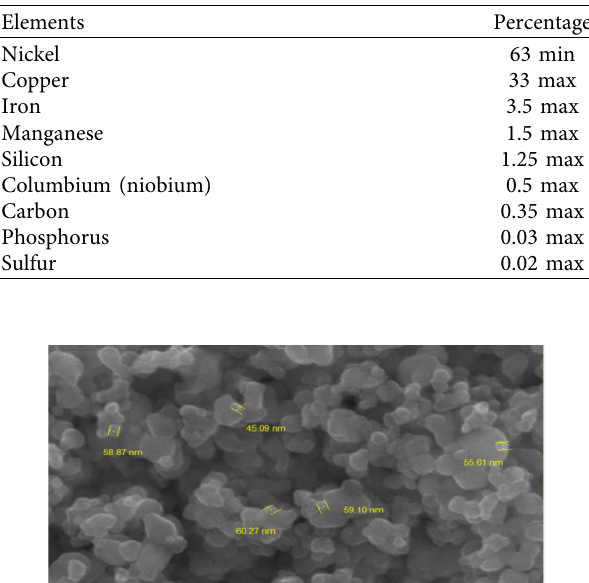
Table 1: Elemental composition of ASTM A494 M35-1 nickel alloy.